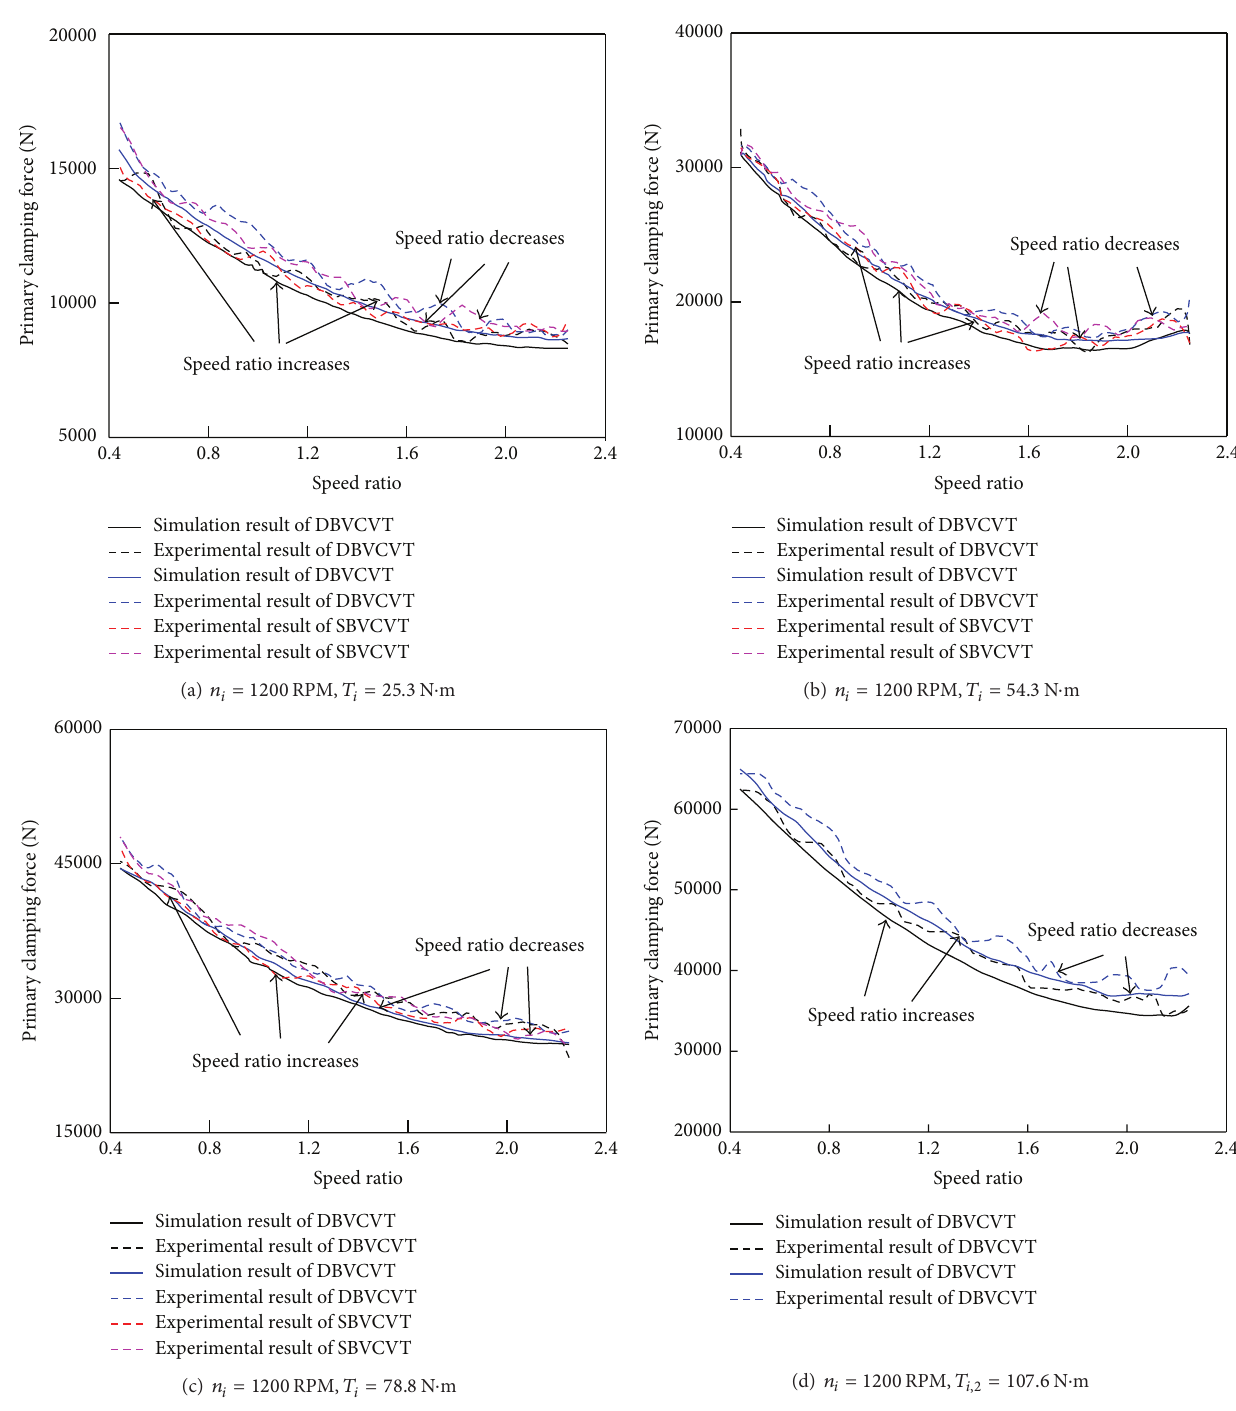
Figure 9: Comparison of simulation and experimental results of speed ratio responses under 𝑛 𝑖 = 1200